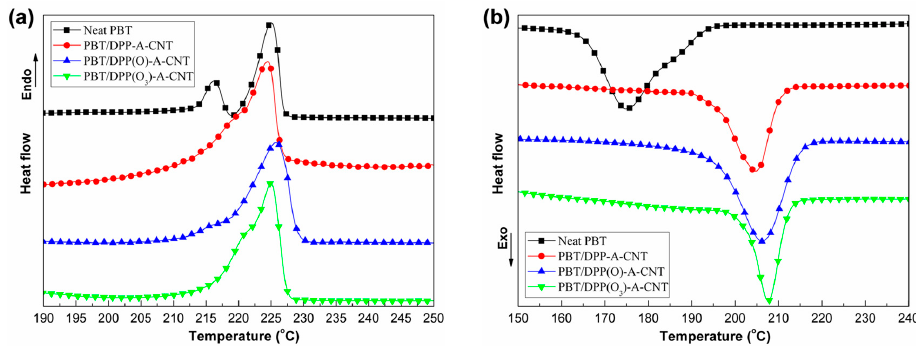
Figure 5. DSC curves of: heating scan ( a ); and non-isothermal crystallization ( b ) at a rate of 10 °C/min for neat PBT, PBT/DPP-A-CNT, PBT/DPP(O)-A-CNT and PBT/DPP(O 3 )-A-CNT. Table 1. Calorimetric data of the melting and non-isothermal crystallization processes for each sample ( T m , melting peak temperature of 2nd heating; T c , crystallization peak temperature of 2nd cooling). Sample No. T m (°C) T c (°C)